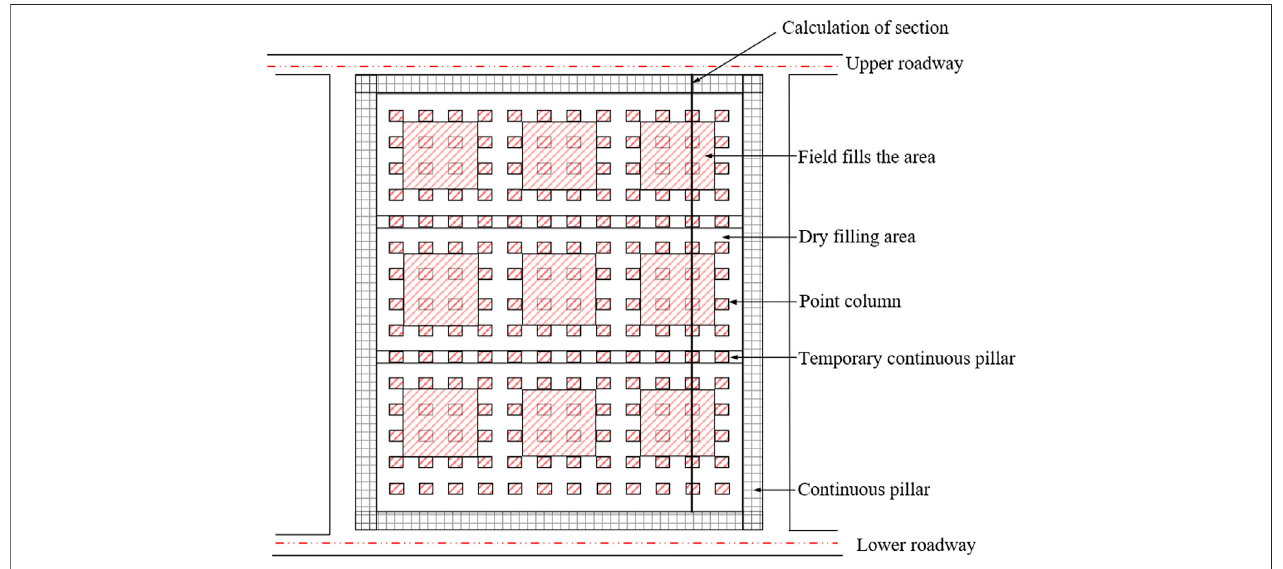
FIGURE 5 | Schematic diagram of fi lling scheme.